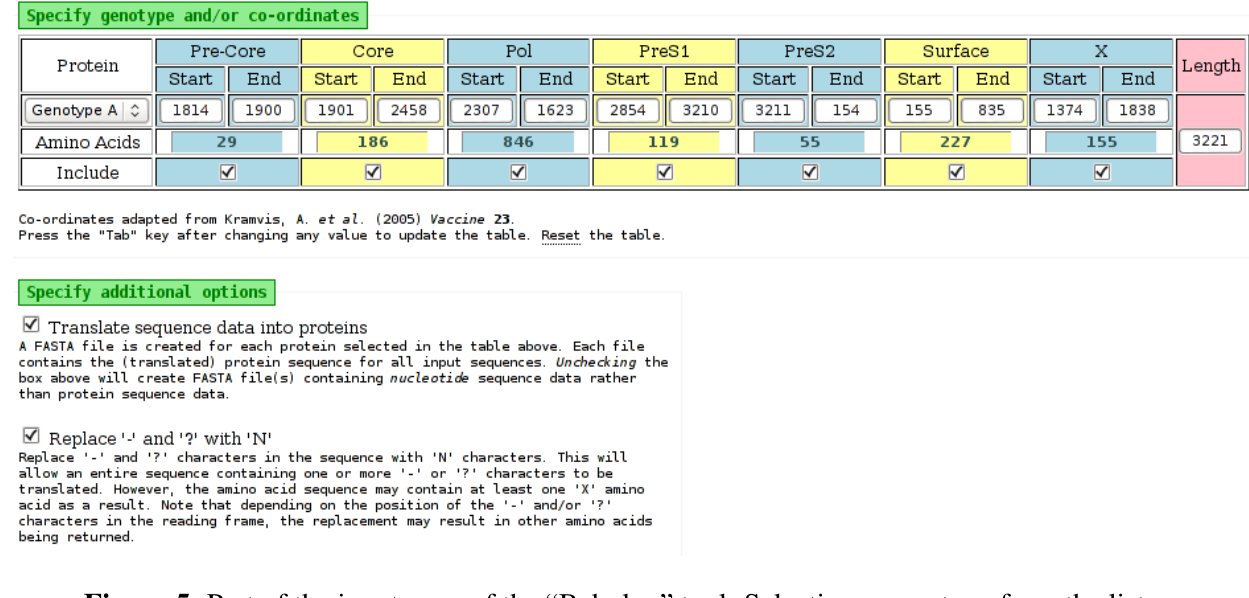
Figure 5. Part of the input page of the “Babylon” tool. Selecting a genotype from the list on the left will populate the nucleotide positions for each protein with default values from